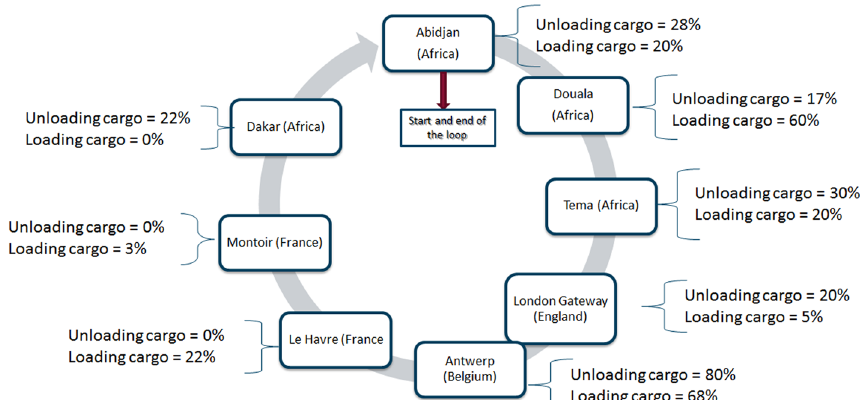
Fig. 6 Order of ports and (un)loading share (non-transshipment and transshipment cargo)—scenario 2